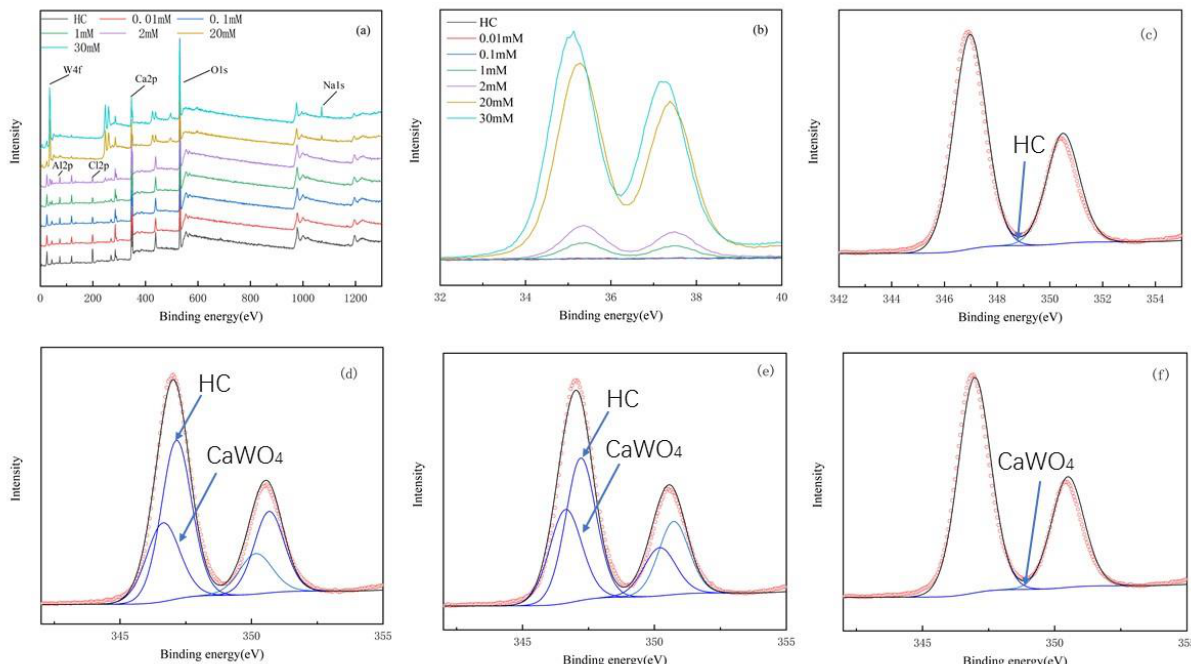
Figure 5. XPS analysis of hydrocalumite before and after its reaction with aqueous tungstate. Full range ( a ); W4f spectra of solids after tungsten removal at different initial tungsten concentrations ( b ); Ca2p spectra of hydrocalumite ( c ); Ca2p spectra of solids after tungsten removal at initial tung- sten concentrations of 1 mmol/L ( d ), 2 mmol/L, ( e ) and 30 mmol/L ( f ). ( c – f ): Original data; Fitting results.